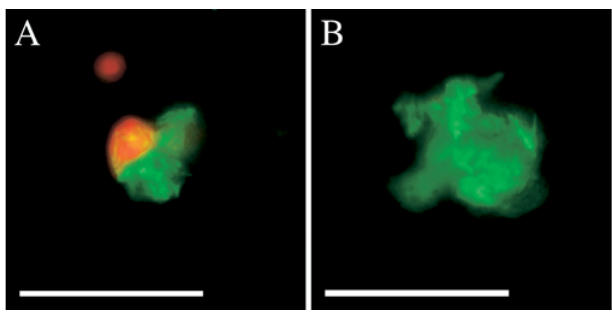
Figure 9. WT Aggregates Are More Likely to Have TUNEL-Positive Cells Than D RD1 Aggregates Representative fluorescent images of aggregates following TUNEL staining of 6-d postfertilization embryos infected with 71 green- fluorescent WT (A), or 474 green-fluorescent D RD1 (B) bacteria. TUNEL staining is imaged with red fluorescence, and colocalization with green-fluorescent bacteria appears yellow. Scale bar, 100 l m. DOI: 10.1371/journal.pbio.0020367.g009